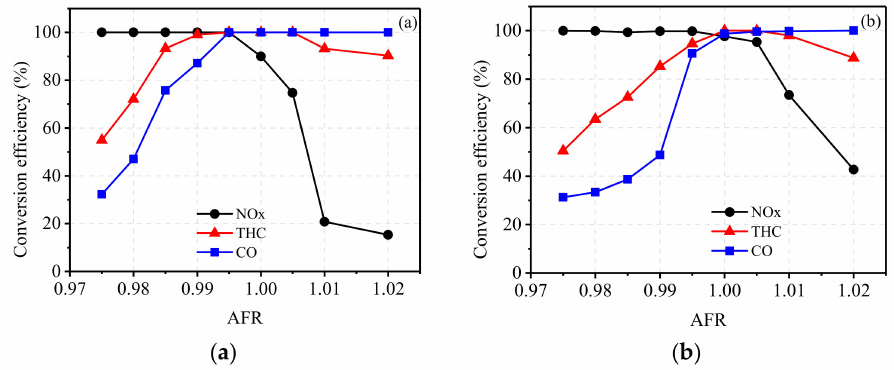
Figure 6. Conversion e ffi ciency of emissions under the conditions of ( a ) 2100 N · m at 1300 r / min and ( b ) 1700 N · m at 1800 r / min.